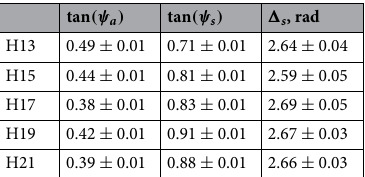
Table 1. Parameters | r p | / | r s | = tan ψ and (cid:31) s for individual harmonic, where indices a and s denote the analyzer and spectrometer, respectively.